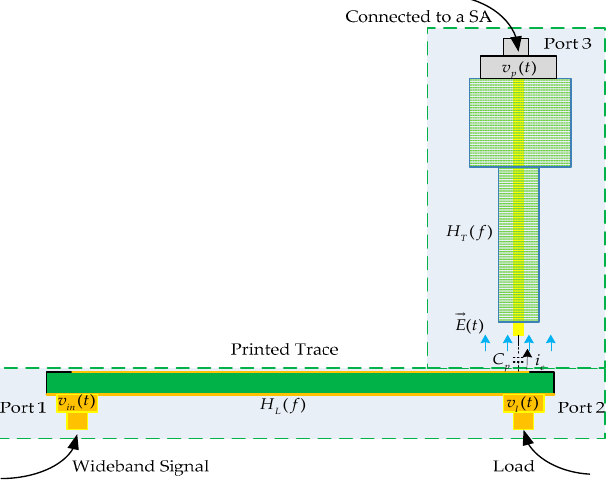
Figure 1. Analysis model of a microstrip line electric probe and printed trace system.